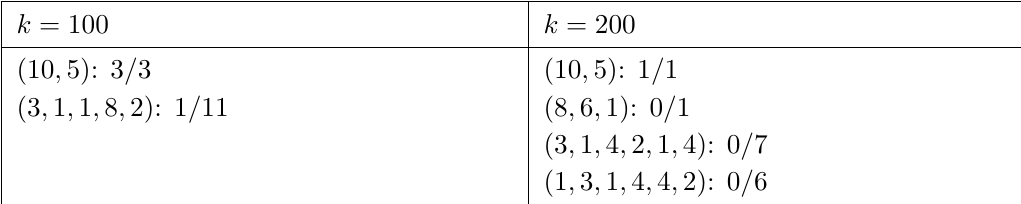
Table 3 . Kam ness for L 26 on su (4) .